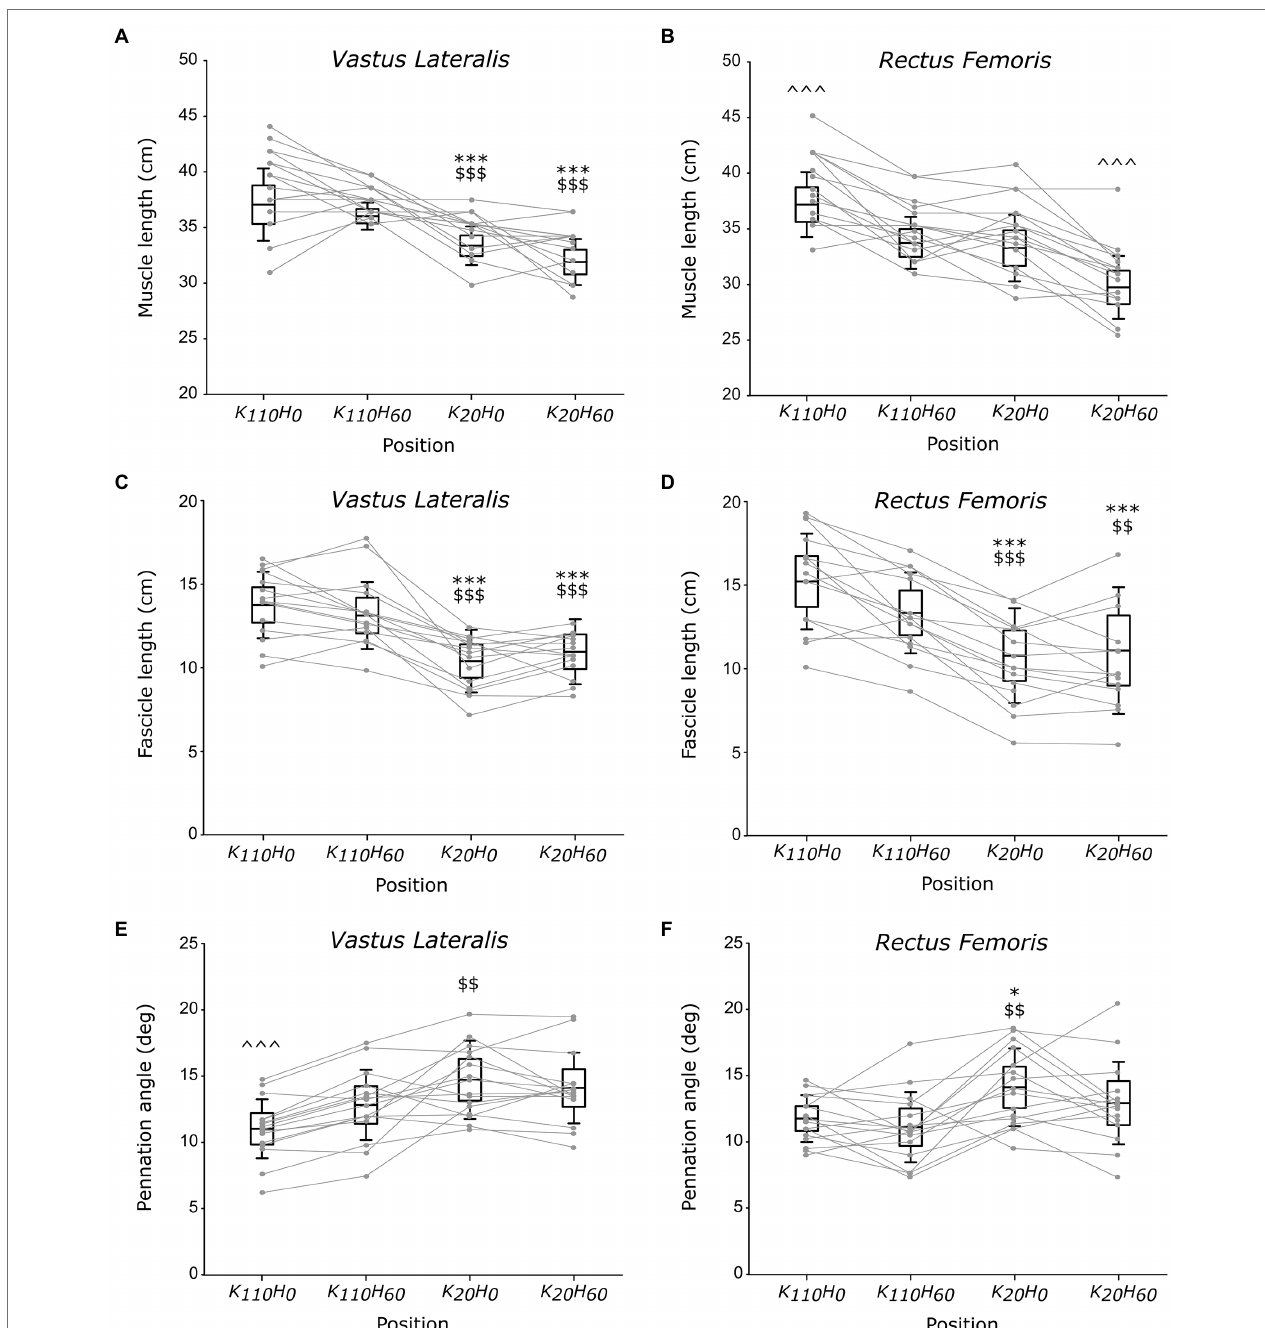
FIGURE 4 | Architectural parameters of the vastus lateralis (VL) and rectus femoris (RF) muscles; muscle (A,B) and fascicle (C,D) length and pennation angle ( E,F ; n = 16). Black boxes and whisker plots represent the average values for all participants (line: mean, box: 95% CI, and whiskers: SD), individual data are provided in grey. For each muscle, * or $ or ^ denotes significant difference from position K 110 H 0 or K 110 H 60 or all other positions, respectively. One, two, or three symbols indicate difference at p < 0.05, p < 0.01, or p < 0.001,